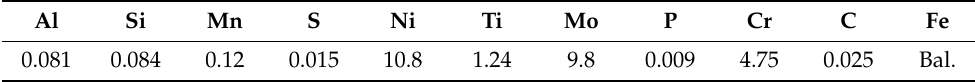
Table 1. Chemical Composition of M9.8